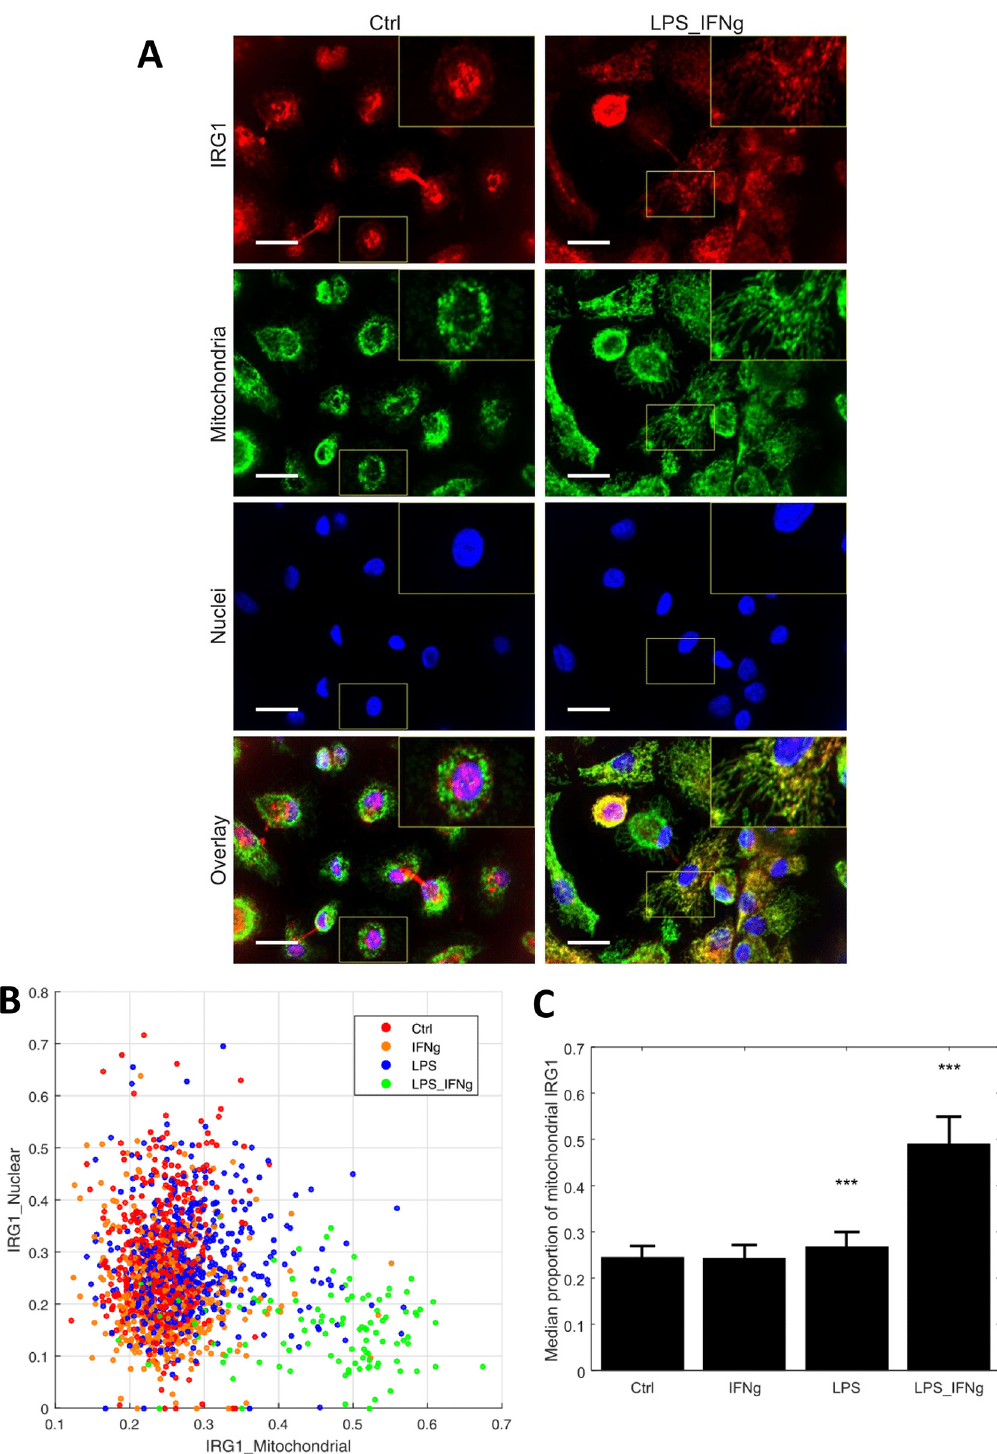
Fig 3. Mitochondrial accumulation of IRG1/CAD under pro-inflammatory conditions. ( A ) Immunofluorescence images show maximum projections from 11 confocal planes. Scale bars indicate 20 μ m. Additionally magnified image regions and 2x magnified inlets are highlighted with yellow boxes. ( B ) IRG1/CAD was detected in nuclei, mitochondria and cytoplasmic vesicular structures. To quantify mitochondrial accumulation of IRG1/CAD, nuclear and mitochondrial proportions of single cell IRG1/CAD positive pixels were analysed. ( C ) Bars represent the median proportion of mitochondrial IRG1/CAD in untreated cells, LPS, IFN γ and LPS with IFN γ treated cells. Error bars show median absolute deviations. Statistical testing was done via two sided Wilcoxon rank sum tests. *** p < 0.001 (Wilcoxon rank sum test). doi:10.1371/journal.pone.0149050.g003 PLOS ONE | DOI:10.1371/journal.pone.0149050 February 12,